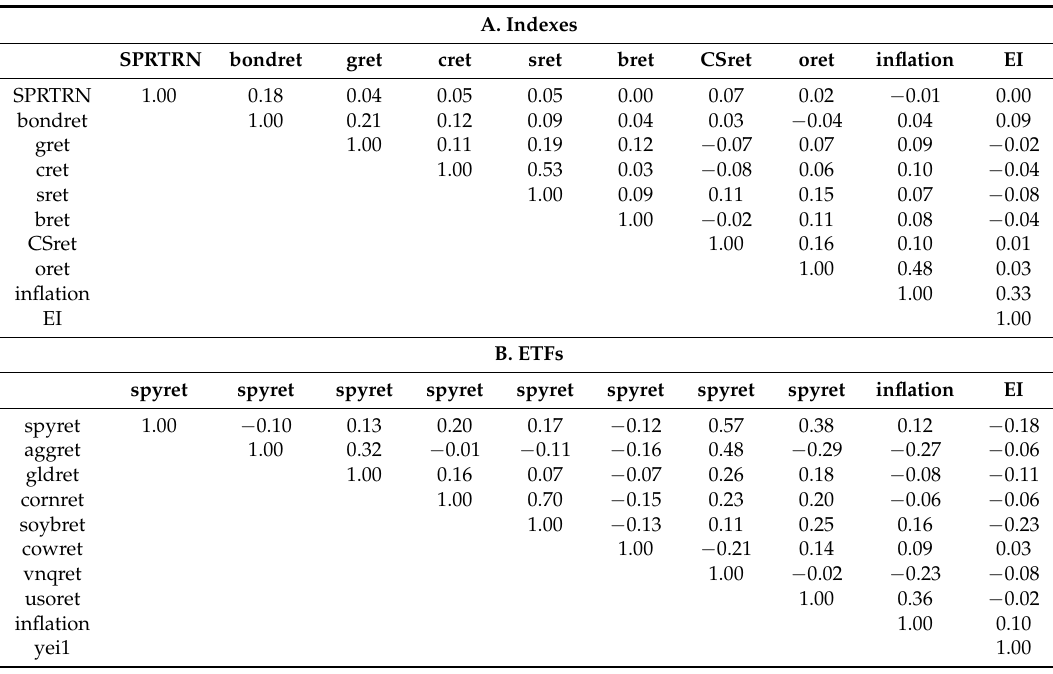
Table 3. Correlation